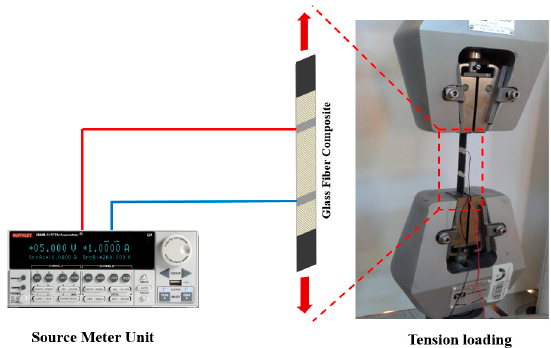
Figure 3. Schematic of electrical resistance measurement of glass fiber composite coupons during tension tests.